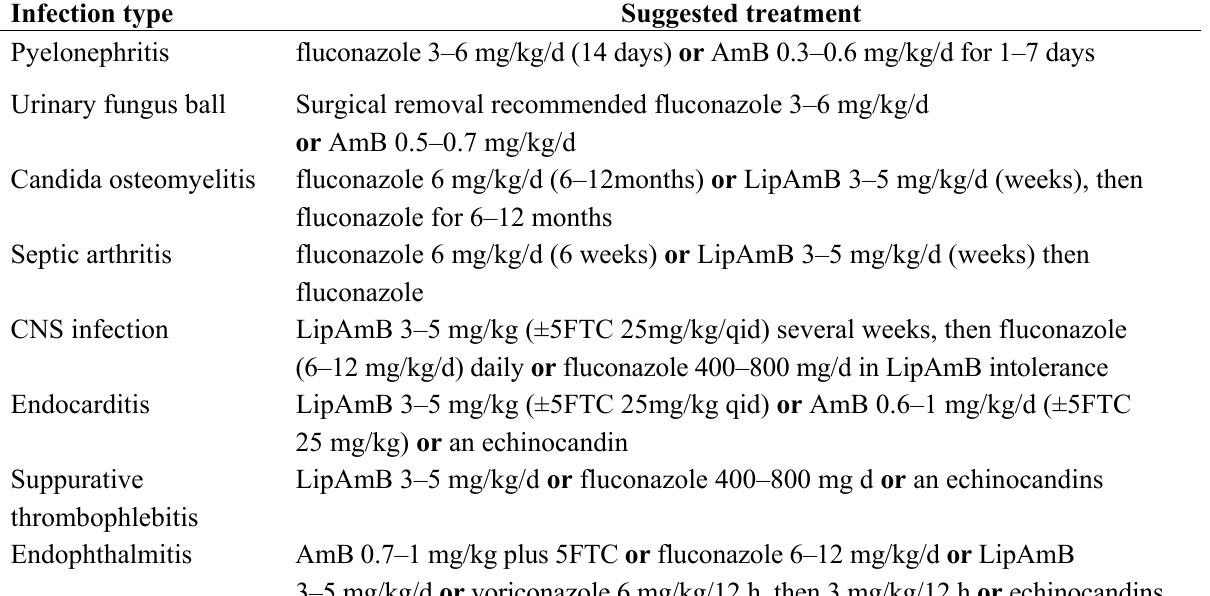
Table 8. Recommended therapy for localised forms of invasive candidiasis according to 2009 IDSA